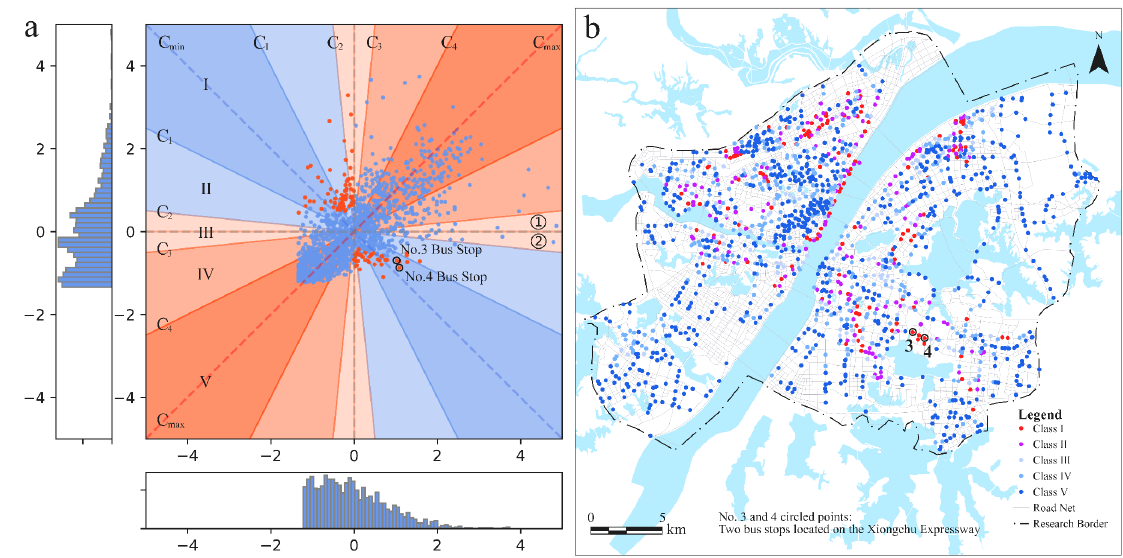
Figure 7. The CDI subclassification results. ( a ) The subclassification result for Moran scatterplot ( b ) The cor-responding subclassification results of bus stops.